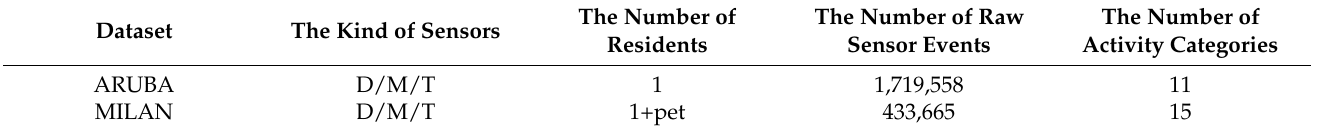
Table 1. Dataset description (D = door switch sensor, M = motion sensor, T = temperature sensor).